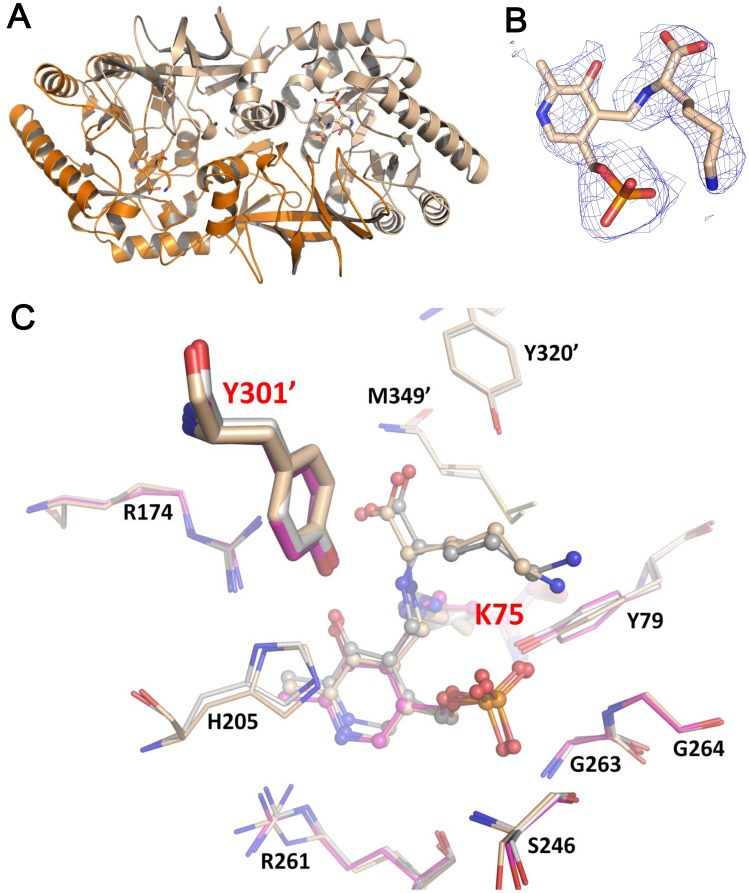
Bar-PLP-L-lysine complex structure.(A) The dimeric Bar is presented as cartoon presentation (chain A, wheat and chain B, orange). PLP and L-lysine are drawn as stick models. (B) The omit Fo-Fc electron density map shows PLP, substrate (L-lysine), and the external aldimine linkage, contoured at the 1.0-σ level. (C) Structural comparison of the binding pockets for apo Bar (magenta), L-lysine-liganded Bar (wheat) structures and Bar-PLY (gray) docking model. PLP, substrate L-Lys and catalytic K75 are shown as ball-and-stick models, whereas catalytic Y301′ from the other protomer is drawn as heavy sticks. The rest of surrounding residues are shown as thin sticks. Oxygen, nitrogen, and phosphate atoms are colored in red, blue, and orange, respectively.